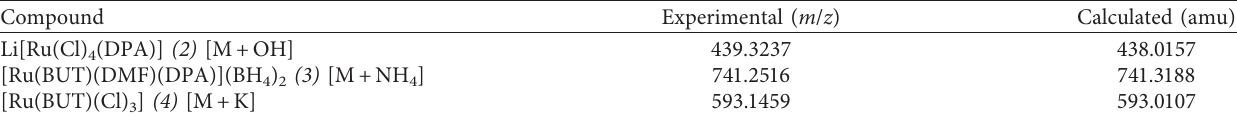
Table 3: Experimental and calculated mass of